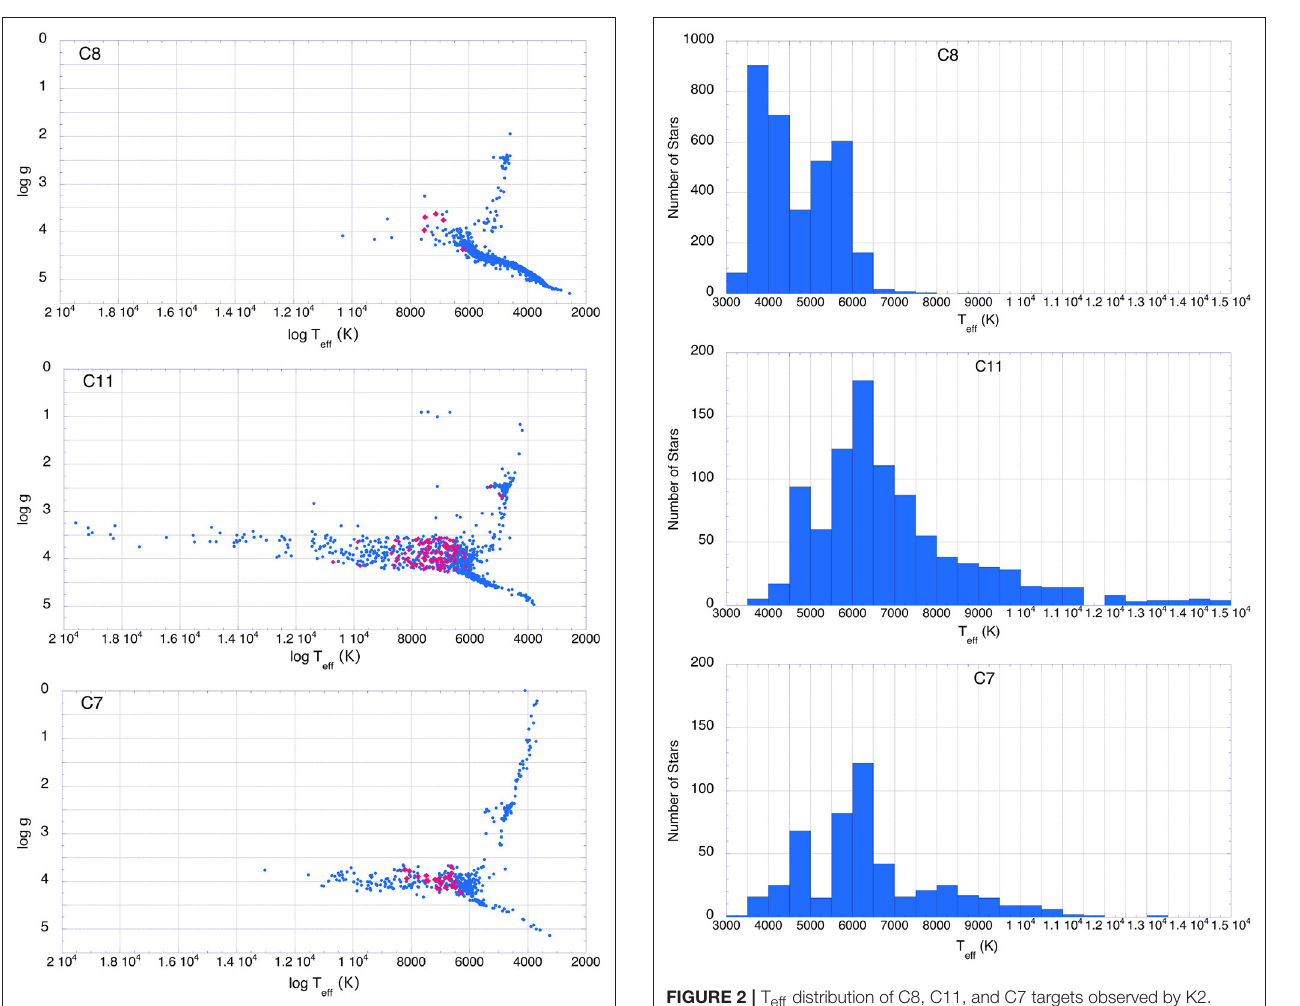
FIGURE 1 | Spectroscopic H-R diagram, log surface gravity vs. log T eff , for C8, C11, and C7 targets observed by K2. Red dots label δ Sct candidates.